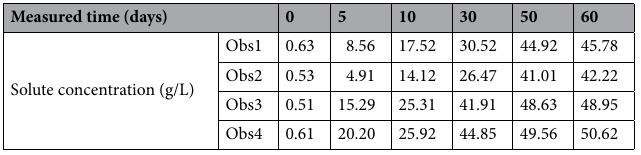
Table 3. Relationship between solute concentration and measured